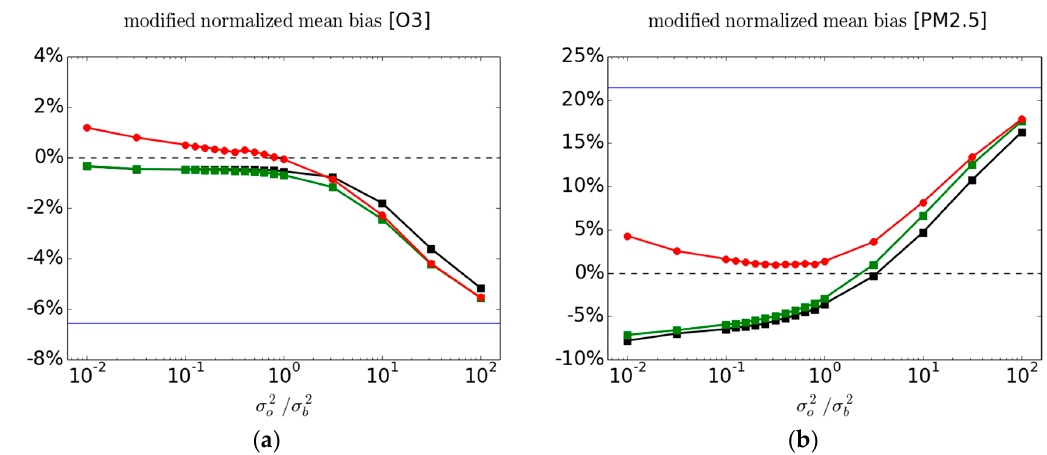
Figure 7. Modified normalized mean bias (MNMB) between observation and analysis for ( a ) O 3 and ( b ) PM 2.5 for both active and cross-validation passive observations as a function of 22 / bo σσγ= . The red, black and green curves are as in Figure 2.